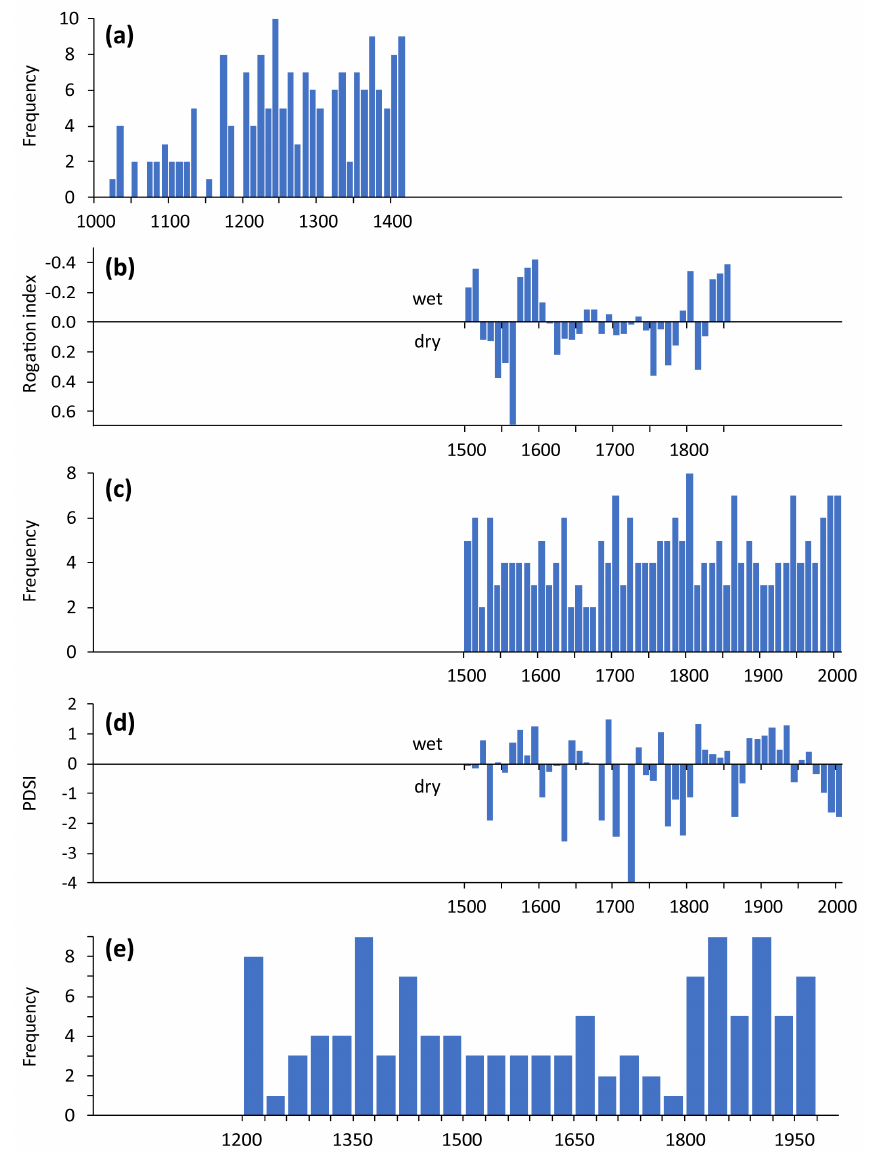
Figure 9. Long-term fluctuations in a range of documentary-based drought series across Europe: (a) decadal frequencies of unusually dry JJA months in western Europe, 1000–1419 (Alexandre, 1987); (b) decadal means of the weighted Drought Rogation Index for the Catalonian coast of north-eastern Iberia, 1501–1860 (Oliva et al., 2018); (c) decadal frequencies of droughts in the Czech Lands, 1501–2010 (Brázdil et al., 2013); (d) decadal means of annual PDSI in the Czech Lands, 1501–2010 (Brázdil et al., 2016a); (e) 30-year frequencies of extremely dry MAM–JJA seasons in the European non-chernozem part of the former Soviet Union, 1201–1980 (Lyakhov,